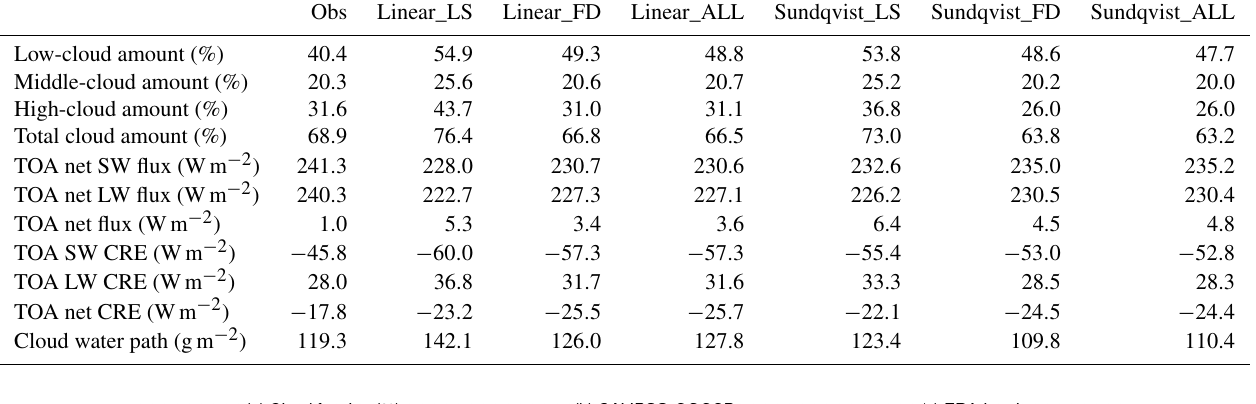
Table 3. Global and annual mean climatological properties of observations and different Isca simulations, which are summarized in Table 2. The net fluxes in the table are positive downward. The observed cloud amounts are from the CALIPSO-GOCCP data set (2007–2015), the radiative fluxes and cloud radiative effects (CREs) at the TOA are from the CERES-EBAF data set (2001–2018), and the cloud water path (sum of liquid and ice) is from the CloudSat data product.